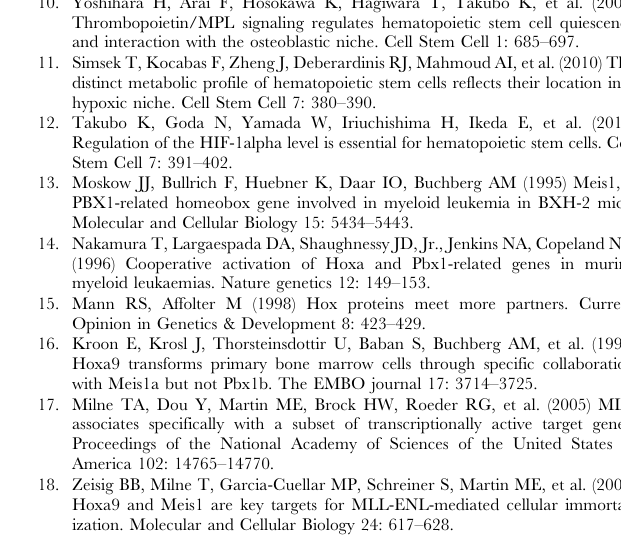
Figure S4 Loss of Meis1 abrogates megakaryocyte lineage differentiation in the bone marrow. Representative flow cytometric profiles of megakaryocytic-lineage cell populations